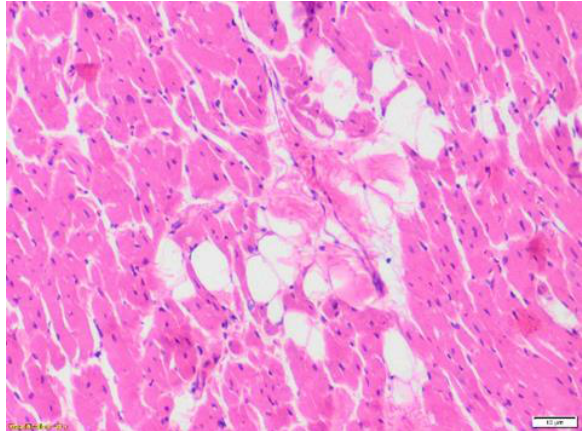
Figure 2. Liver, ( A ) focal hepatic necrosis, ( B ) perivescular lymphoplasmocytes and mecrophages infiltration, ( C ) perivescular inflammatory cells infiltrares, ( D ) vacuolar degeneration of hepato- cytes. ( E ) Spleen, necrotic areas infiltrated by macrophages and plasma cells. Heart ( F ) expansion of epicardium and infiltration by inflammatory cells, extension of cells infiltrate to myocardium, subepicardial myocarditis, ( G ) vacuolization of cardiac myocytes. Hematoxylin and eosin stain, magnification × 40.